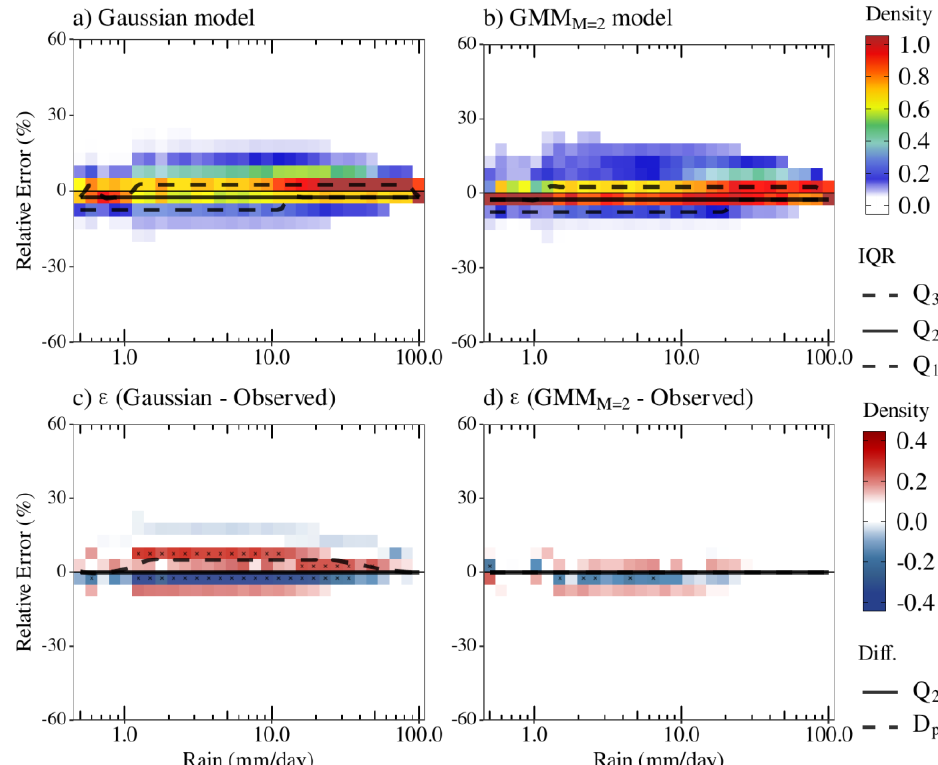
Figure 7. Density scatterplot of the ( a ) Gaussian and the ( b ) GMM (with M = 2) models and their respective residuals ( c , d ) in representing the relative error distributions ( y -axis, in %) as a function of the precipitation ( x -axis, in mm day −1 ) for the RE_C 04 experiment, during the JJA of 2014 and over land surfaces (between 55° N/S global zones). Black crosses indicate residual values above/below the ±0.2 density values. Solid and dashed black lines in c-d correspond to the differences between the model and the observed median and the density peaks, respectively.